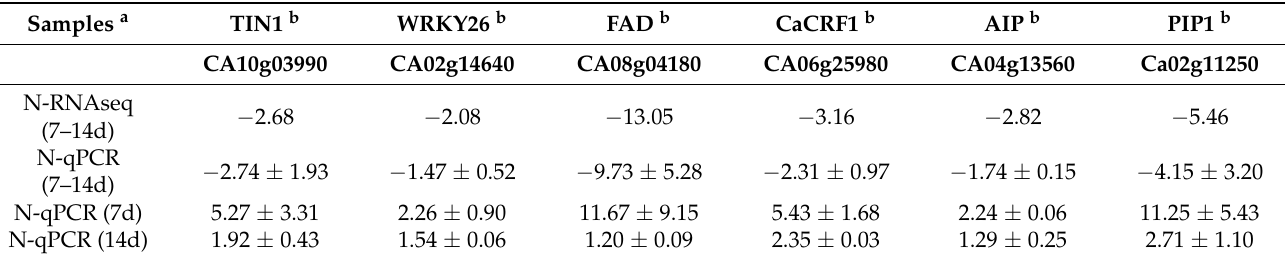
Table 4. qPCR confirmation of RNA sequencing transcriptomic